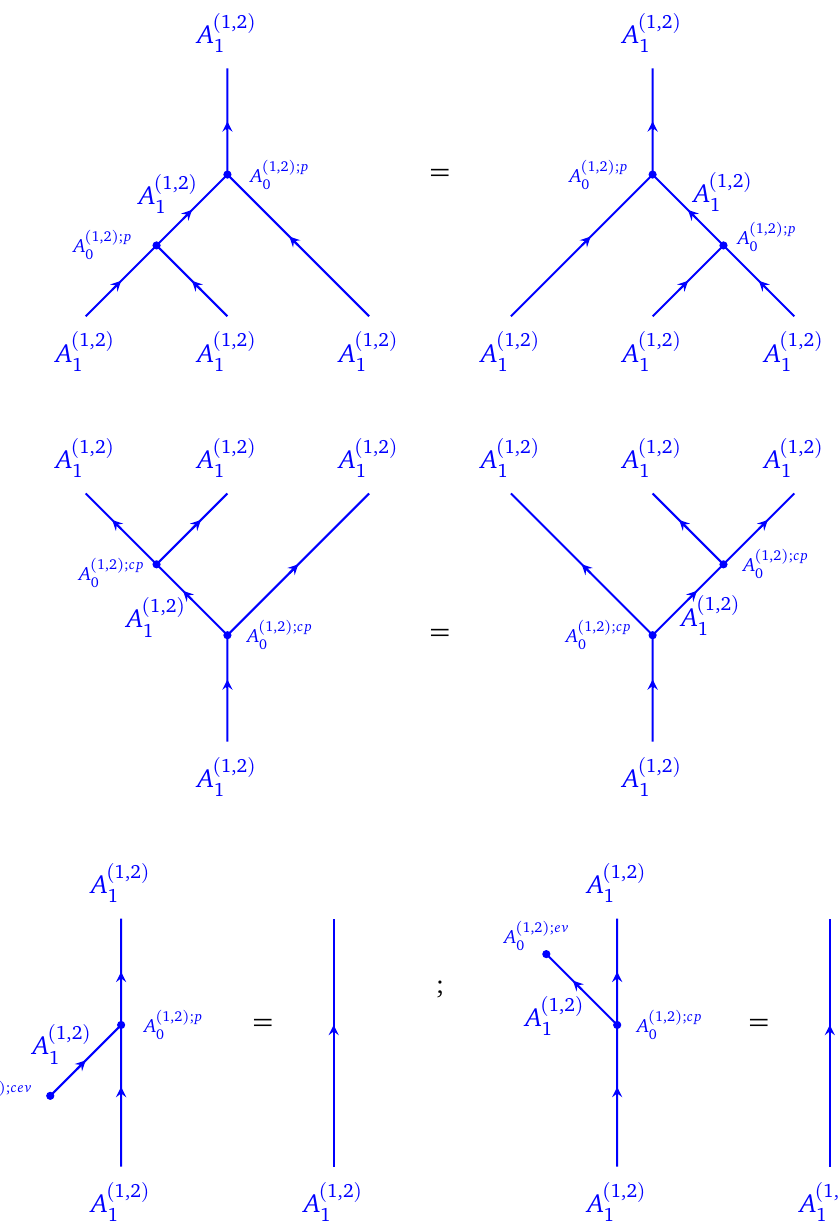
Figure 13: Conditions specified by the morphisms comprising the algebra A p 1,2 q . These conditions follow simply from topological moves performed on the topolog- ical defects D p 1,2 q participating in the definition of these 1